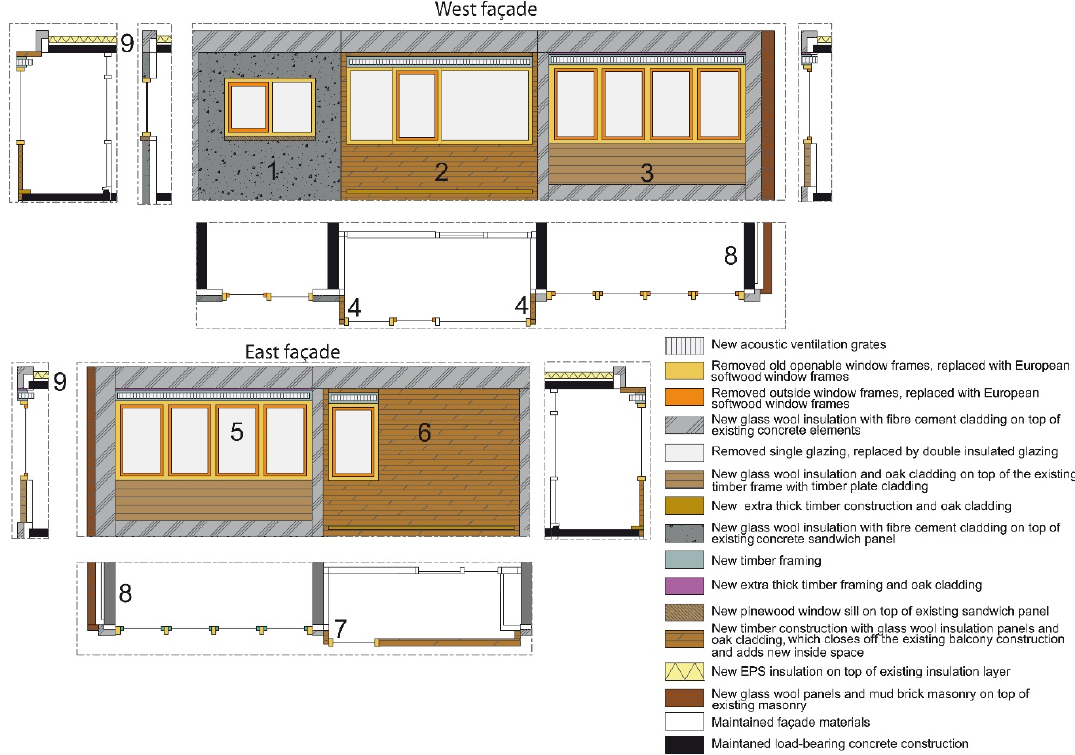
Figure 9. Exterior upgrade design; the balconies were “sealed off” with a new timber cladding wall. All walls were upgraded with an R = 3.5 W/m 2 K insulation and façade cladding.